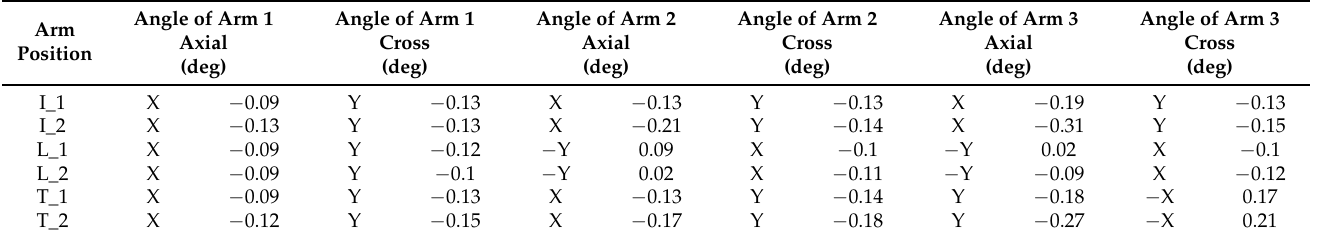
Table 6. Total angular deviations of each arm from the horizontal